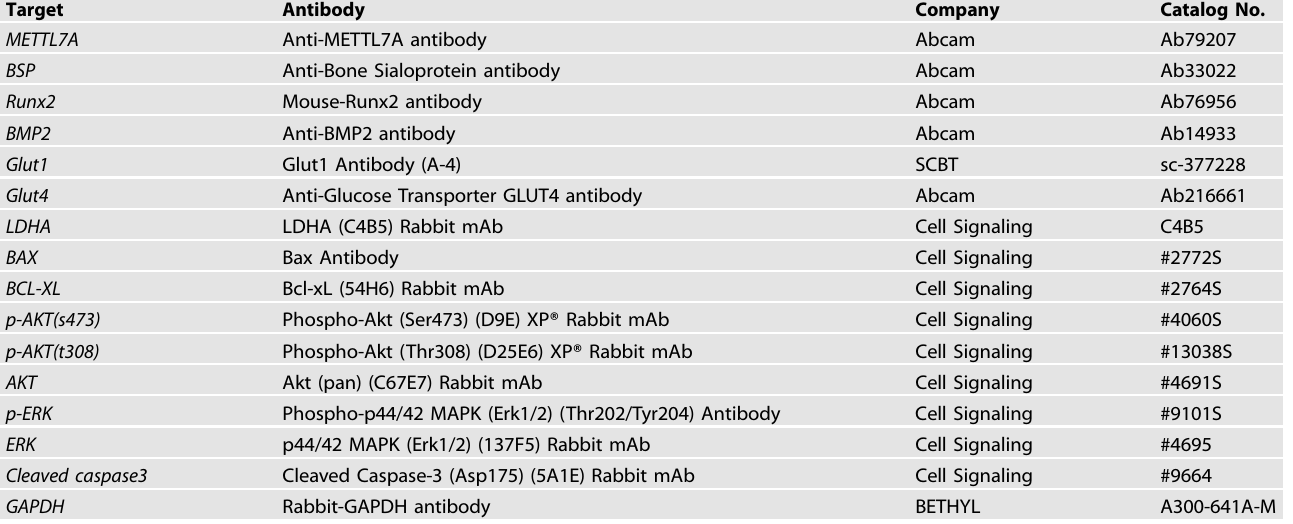
Table 2. Primary antibodies used in western blotting